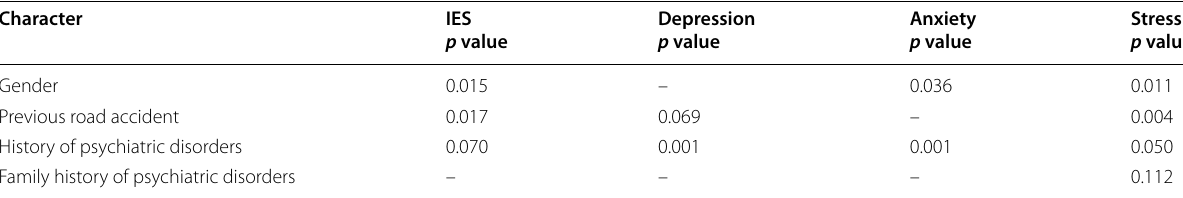
Table 6 Multivariate logistic regression